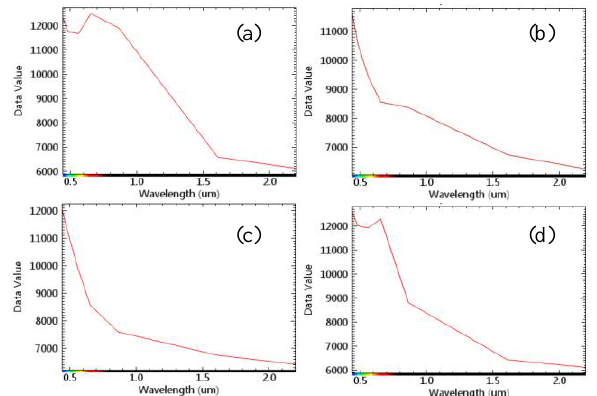
Figure 3 Spectral curves of different water bodies in the OLI sensor image Landsat 8 OLI 2017/05/25, where (a) is the Yellow River, (b) the general river, (c) the deep sea, (d) the